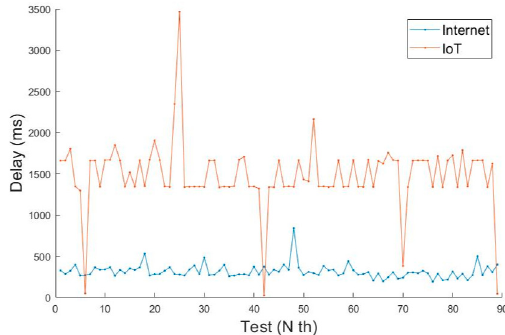
Figure 8. Communication delay of internet and Internet of things (IoT).